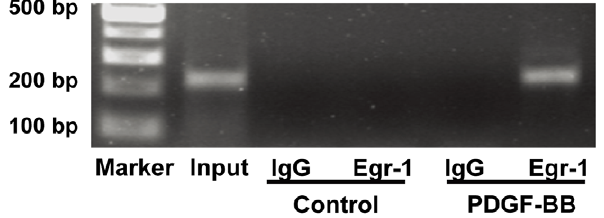
Figure 5. Egr-1 binds to Rad promoter after PDGF treatment. ChIP assay was performed in RASMC stimulated with or without PDGF (20 ng/ml) for 1 hour. After formaldehyde cross-linking, the protein- DNA complexes were recovered using anti-Egr-1 antibody or non- specific IgG. PCR was performed to detect the proximal Rad promoter. PCR products were detected by 2% agarose gel electrophoresis.